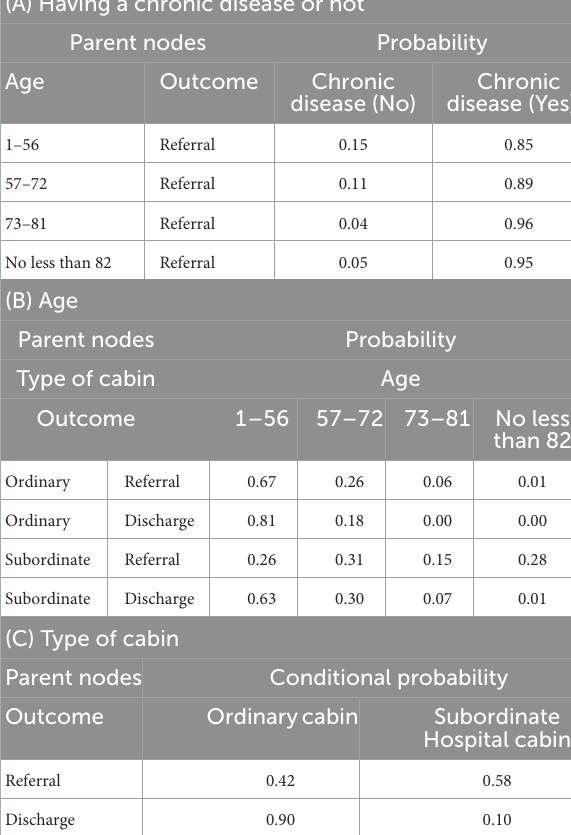
Table 4). The overall correct rates of the model-training